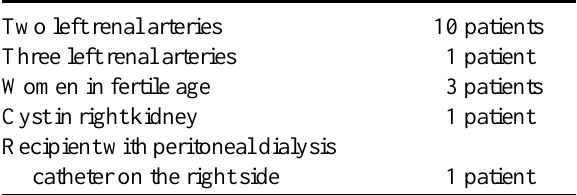
Table 1 – Indications for performing right